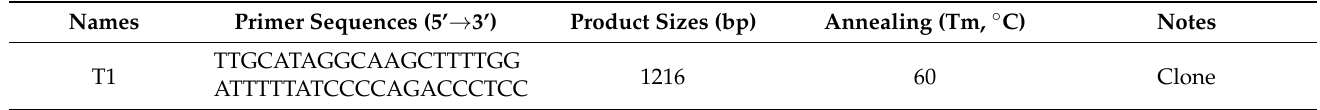
Table 1. Primer sequences information.